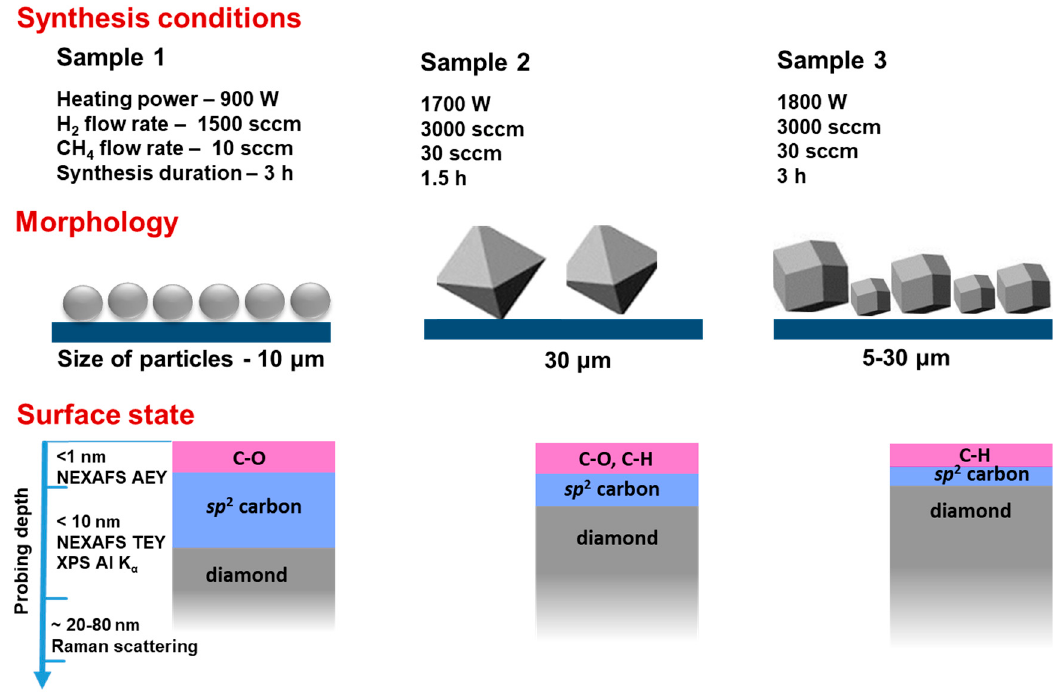
Figure 6. Schematic illustration of diamond film morphology and surface state for the samples grown at di ff erent heating power, methane and hydrogen flow rates, and synthesis duration.